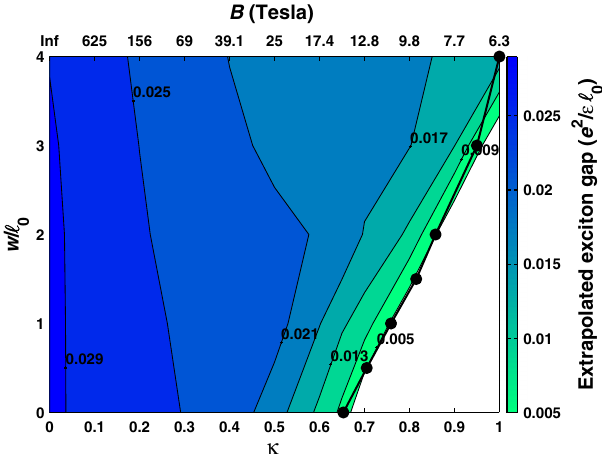
FIG. 9. Color map of the extrapolated exciton gap at S ¼ 3 versus both well width and κ . The contours show specific values of the extrapolated exciton gap. Note that the extrapolation becomes less reliable when approaching the phase transition. The black circles show the transition border determined by the first peak in the entanglement entropy for N ϕ ¼ 29 on the sphere (discussed in Sec. VIII). We do not extrapolate the exciton gap after the phase transition (white area). The top x axis is the magnetic field for GaAs